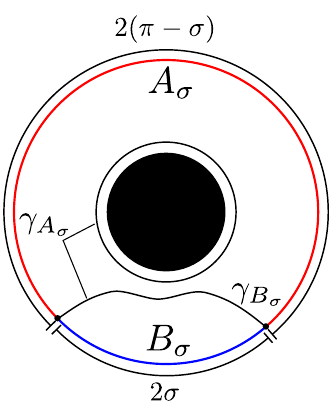
Figure 5 . A constant time slice of the BTZ black hole geometry (4.6). The CFT is de(cid:12)ned on the asymptotic boundary at r ! 1 . For a su(cid:14)ciently large entangling region A (cid:27) (red) the RT surface (cid:13) A is the union of the RT surface (cid:13) B of its complement B (cid:27) (blue) and the black hole horizon. (cid:27) (cid:27) This implies